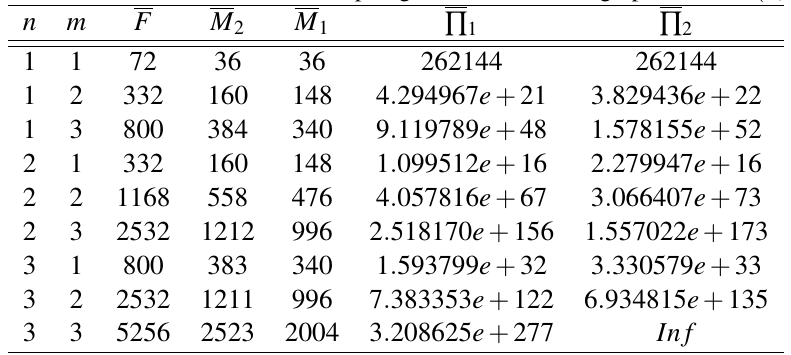
Table 5 MATLAB illustration: » Topological_coindices_of_graphene_sheet ( 3 , 3